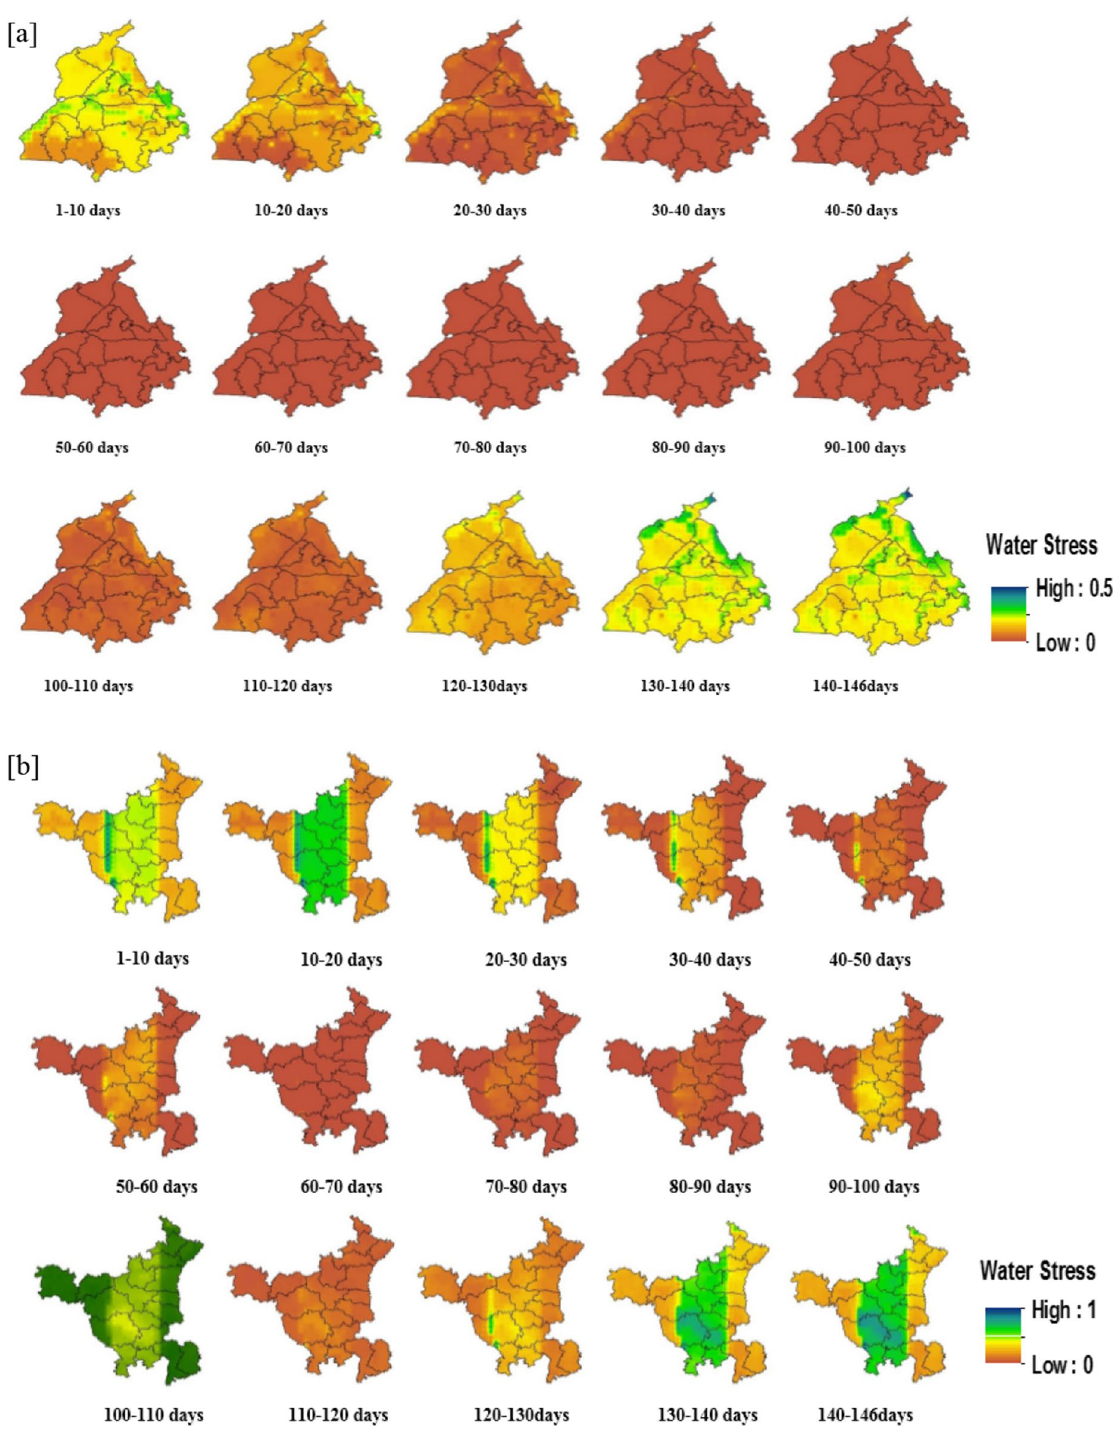
Figure 13. Spatio-temporal distribution maps of rice crop water stress actor at 10-day interval for ( a ) Punjab and ( b ) Haryana during 2009 (Map created at IIRS—https:// www. iirs. gov. in/ inhou selab orato